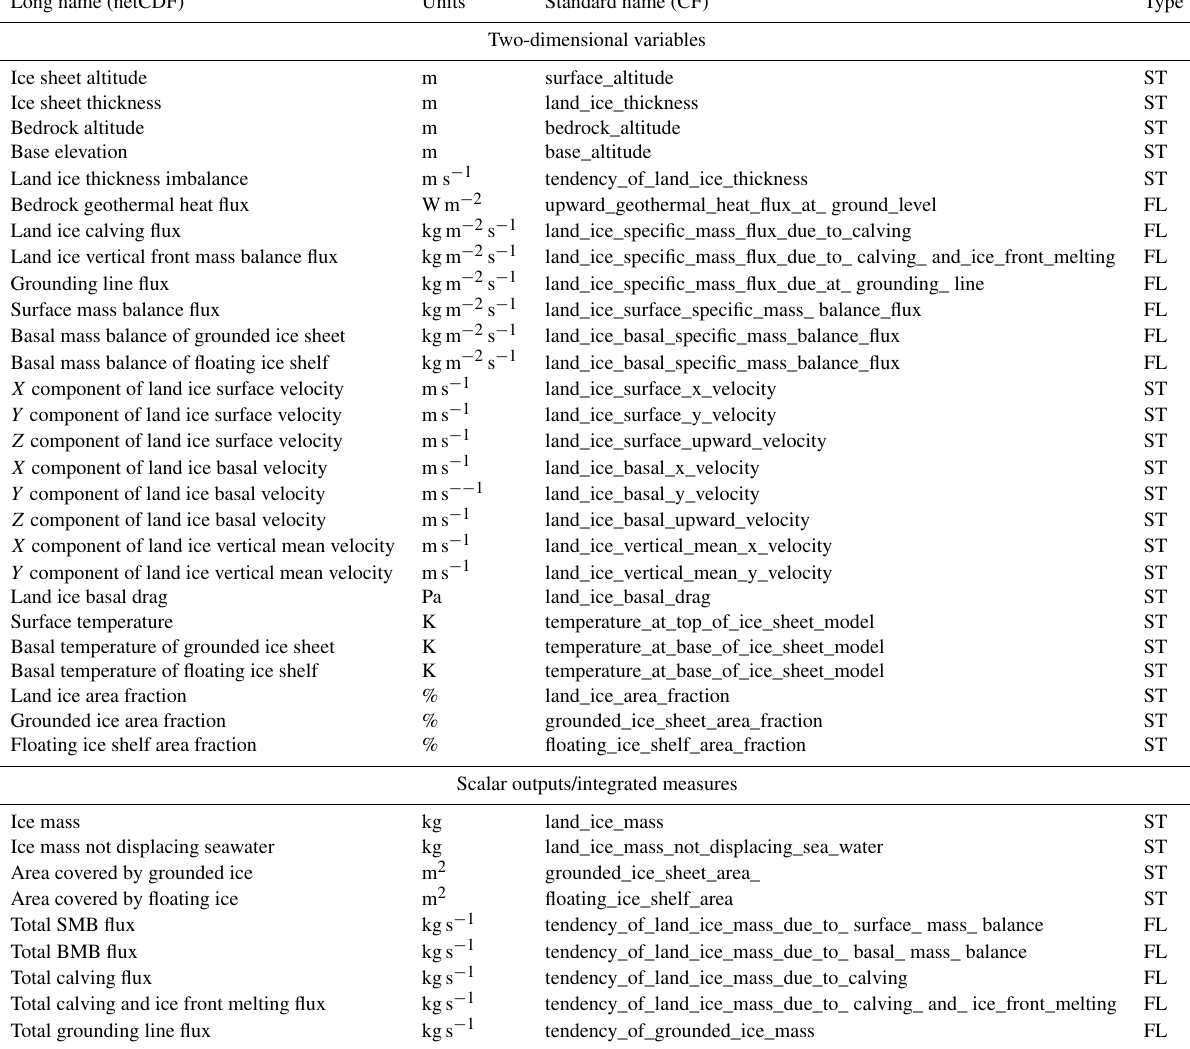
Table B1. Data request for the dynamical ice sheet model submissions. These fields, if applicable to the model, are saved on the regular ISMIP6 ice sheet grid that is the closest to a model native grid and contain yearly output. Type indicates whether the variable is a state variable (ST) or a flux variable